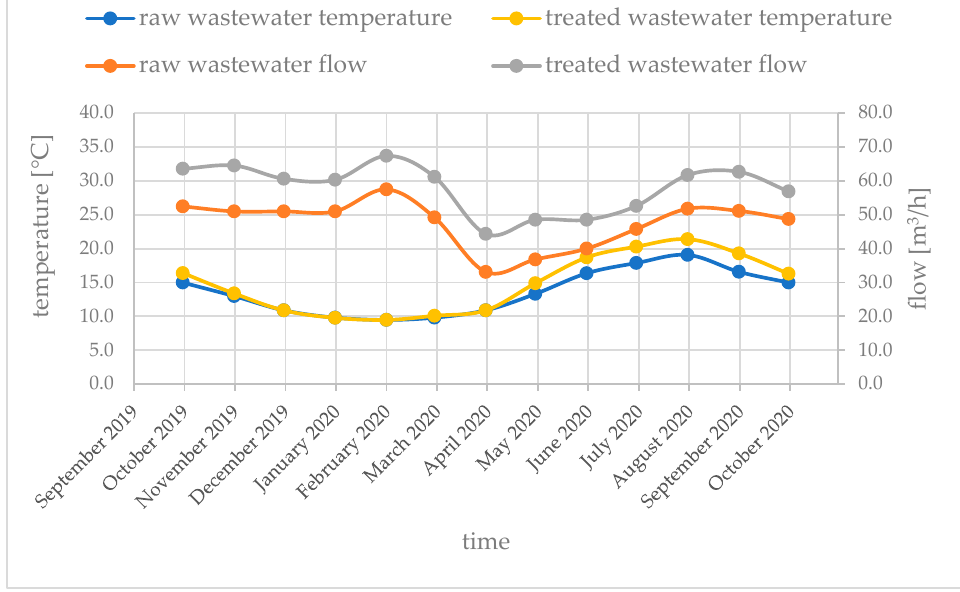
Figure 2. Wastewater flow and temperature variation during the year.